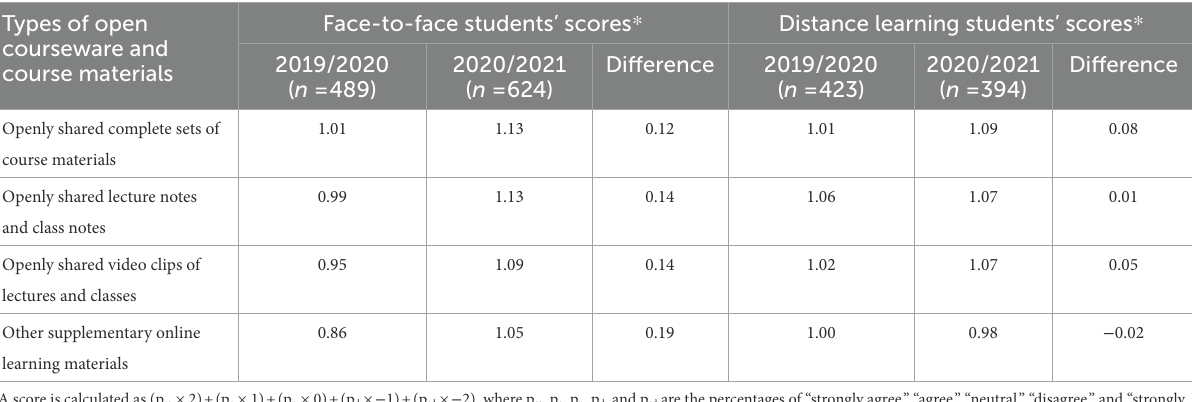
TABLE 2 Usefulness of various types of open courseware and course materials.